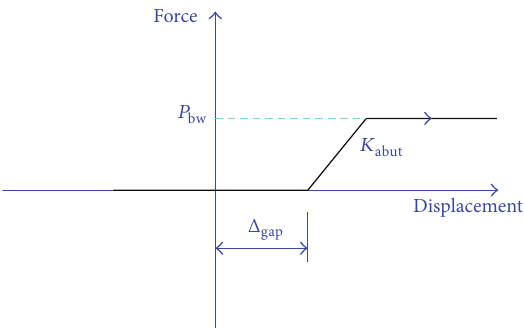
Figure 1: Force-deflection relationship of the